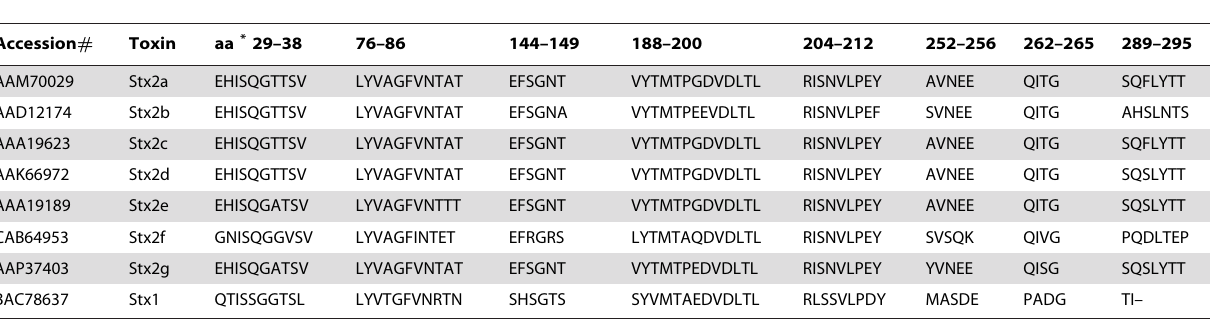
Table 4. Stx2 polyclonal antisera binding to consensus epitopes of A-subunit determined using overlapping Stx2a peptides.